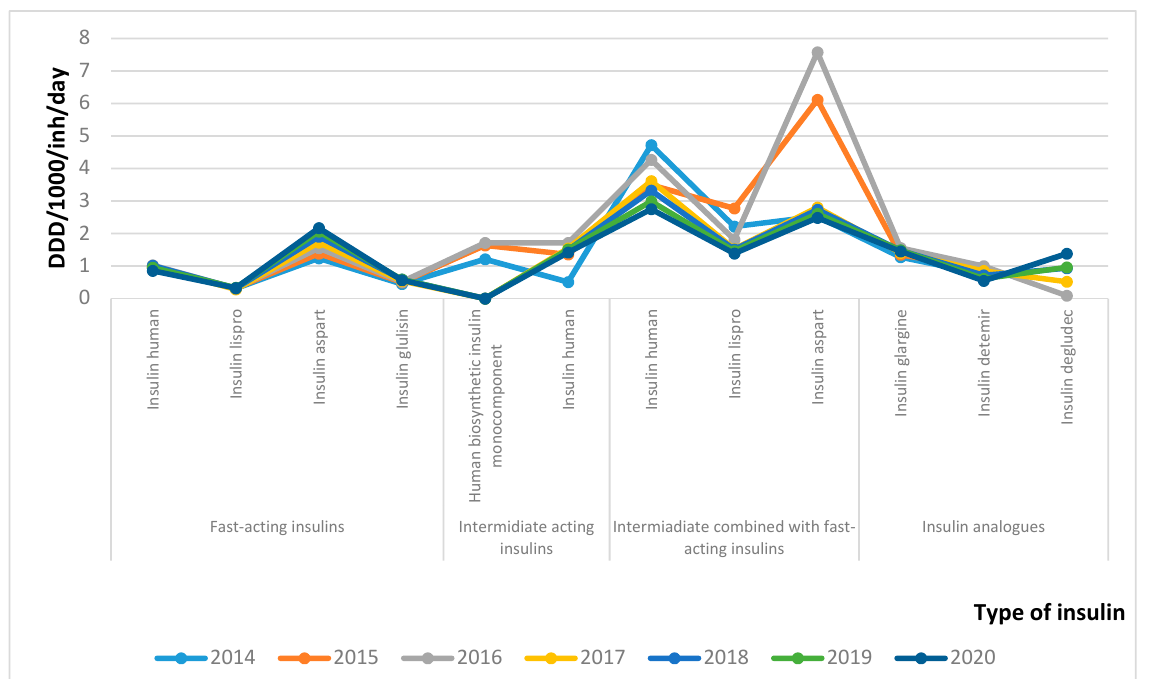
Figure 2. Utilization of insulin in DDD/1000 inh/day.